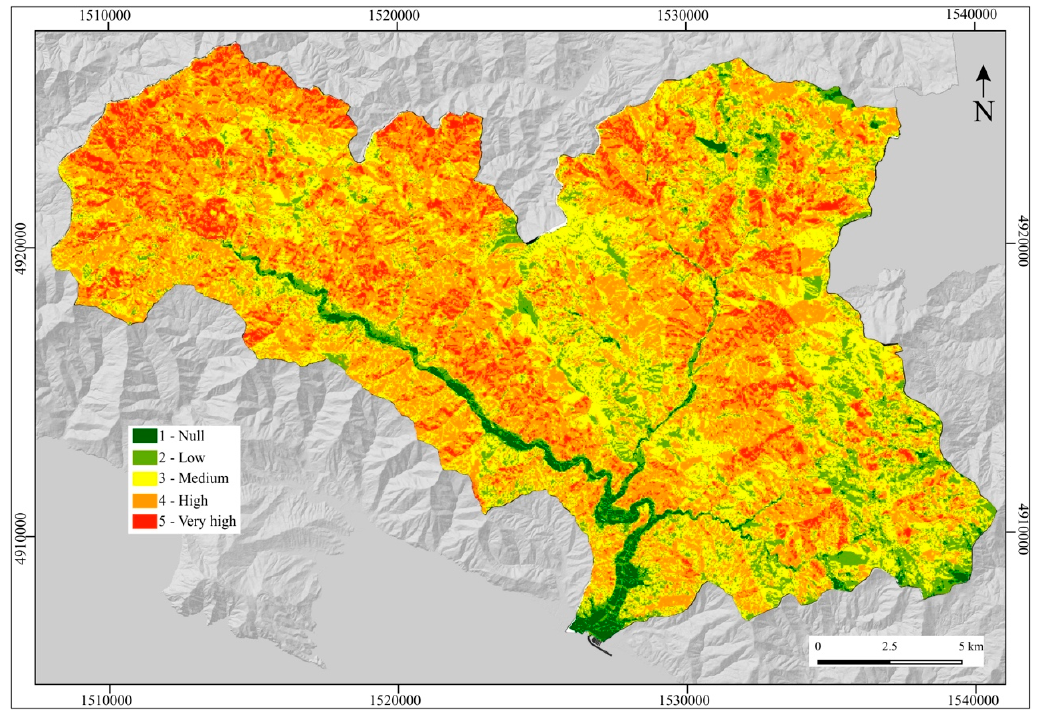
Figure 11. Map of the landslide prone areas of the Entella River catchment obtained using all the predisposing factors, including man-made elements and existing landslides.